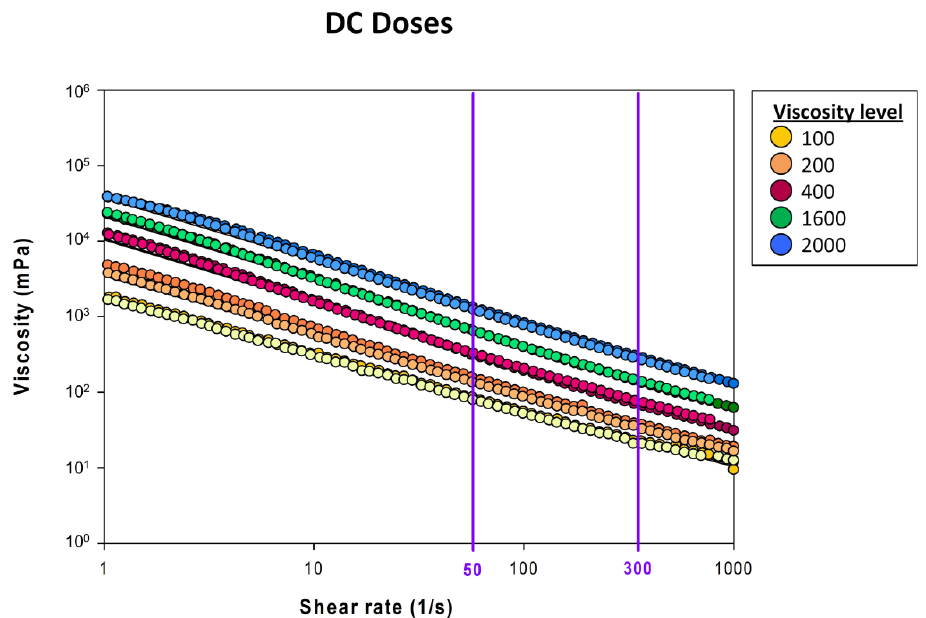
Nutrients 2022 , 14 , 5028 Figure 3. Viscosity curves from a shear rate range of 1–1000 s −1 for daily condition doses before and after oral incubation in healthy volunteers. Dark colors correspond to viscosity levels pre-oral incubation. Soft colors correspond to viscosity post-oral incubation. Purple lines mark the two main shear rate landmarks (50 and 300 s −1 ) during deglutition in patients with oropharyngeal dysphagia. Time effect. A variability of 16% was observed at the 200 mPa·s level for the ShV values assessed at the five different times (Table S2). At 800 mPa·s, the variability in the ShV values was reduced to a maximum of 10%. No significant differences appeared be- tween the ShV values assessed for multiple comparisons, nor between all values. After 120 min, ShV experienced a decrease ranging from 9 to 17% at 200 mPa.s and from 3 to 10% at 800 mPa.s (Figure 4).